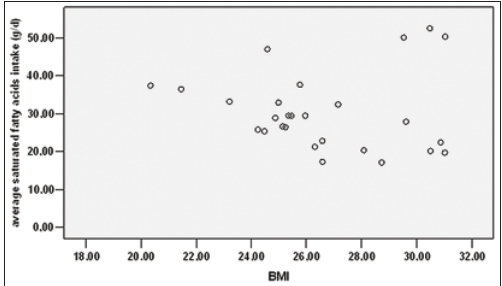
FIGURE 3. Link between BMI and SFAs intake in male students